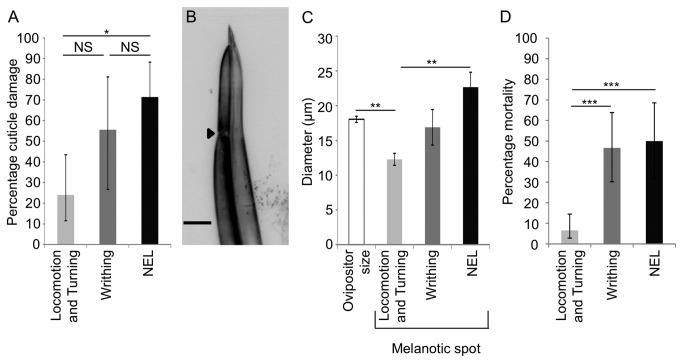
Cuticle penetration and mortality is more frequent in attacks with nociceptive behaviors.(A) Larvae that showed nocifensive escape locomotion showed frequent penetration of the cuticle (N=14, 71% (+17/-26)). Gentle touch-like behaviors (turning and locomotion) rarely showed penetration to the cuticle (N=25, 24% (+19/-13)). Writhing behaviors were associated with an intermediate level of penetration (N=9, 56%, (+26/-29)). Fisher’s Exact Test with Holm-Bonferroni correction. Data are presented as percentages ±95% confidence intervals. (B) Representative photomicrograph of a wasp ovipositor (scale bar=20 µm). The arrowhead indicates the location of the ovipositor clip. (C) The melanotic spot was similar to the diameter of the ovipositor clip (N=12, 18µm, ± .4) when attacks triggered either writhing (N=5, 17µm, ±2.6) or nocifensive escape locomotion (N=9, 23µm, ±2.2). The size of the melanotic spot was smaller than the diameter of the ovipositor clip when larvae that showed non-nociceptive behaviors (N=6, 12µm, ±.9). T-test with Holm-Bonferroni correction. Error bars denote standard error of the mean. (D) Mortality was high in larvae that displayed writhing (N=30, 47%, (+17/-16)) or nocifensive escape locomotion (N=24, 50%, (+19/-19)) relative to larvae that displayed locomotion and turning (N=76, 7%, (+8/-4)) . Fisher’s Exact Test with Holm-Bonferroni correction. Data are presented as percentages ±95% confidence intervals. P<.05=*, P<.01=**, P< .001 =***.